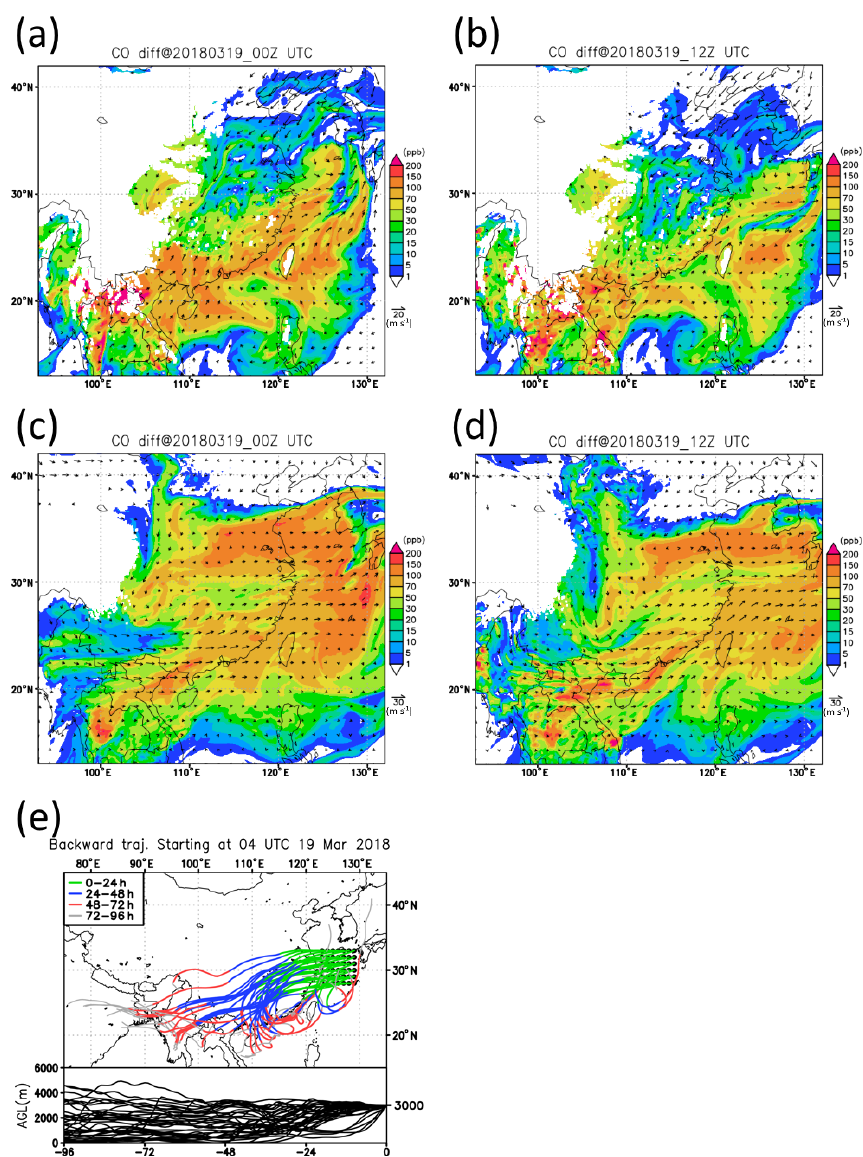
Figure 4. Simulated wind field (ms − 1 ) and concentration (unit: ppb) difference with and without BB emission for CO on 19 March 2018 at 00:00UTC (e, g) and 12:00UTC (f, h) at a 1km altitude (e, f) and 3km altitude (g, h) . (e) The results of the HYSPLIT model backward- trajectory analysis at 300m with multiple points by 1 ◦ × 1 ◦ in the area (28–33 ◦ N, 122–130 ◦ E) of the East China Sea started at 04:00UTC, 19 March